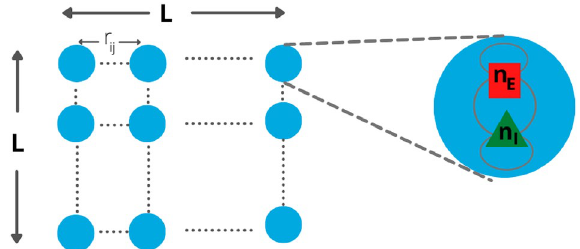
Figure 1. Schematic representation of the 2D model. On each site of the lattice there are n E excitatory and n I inhibitory neurons. Connections between neurons depend on the type of neuron (excitatory or inhibitory) and on the distance measured in lattice spacings. Neurons on the same site have r ij